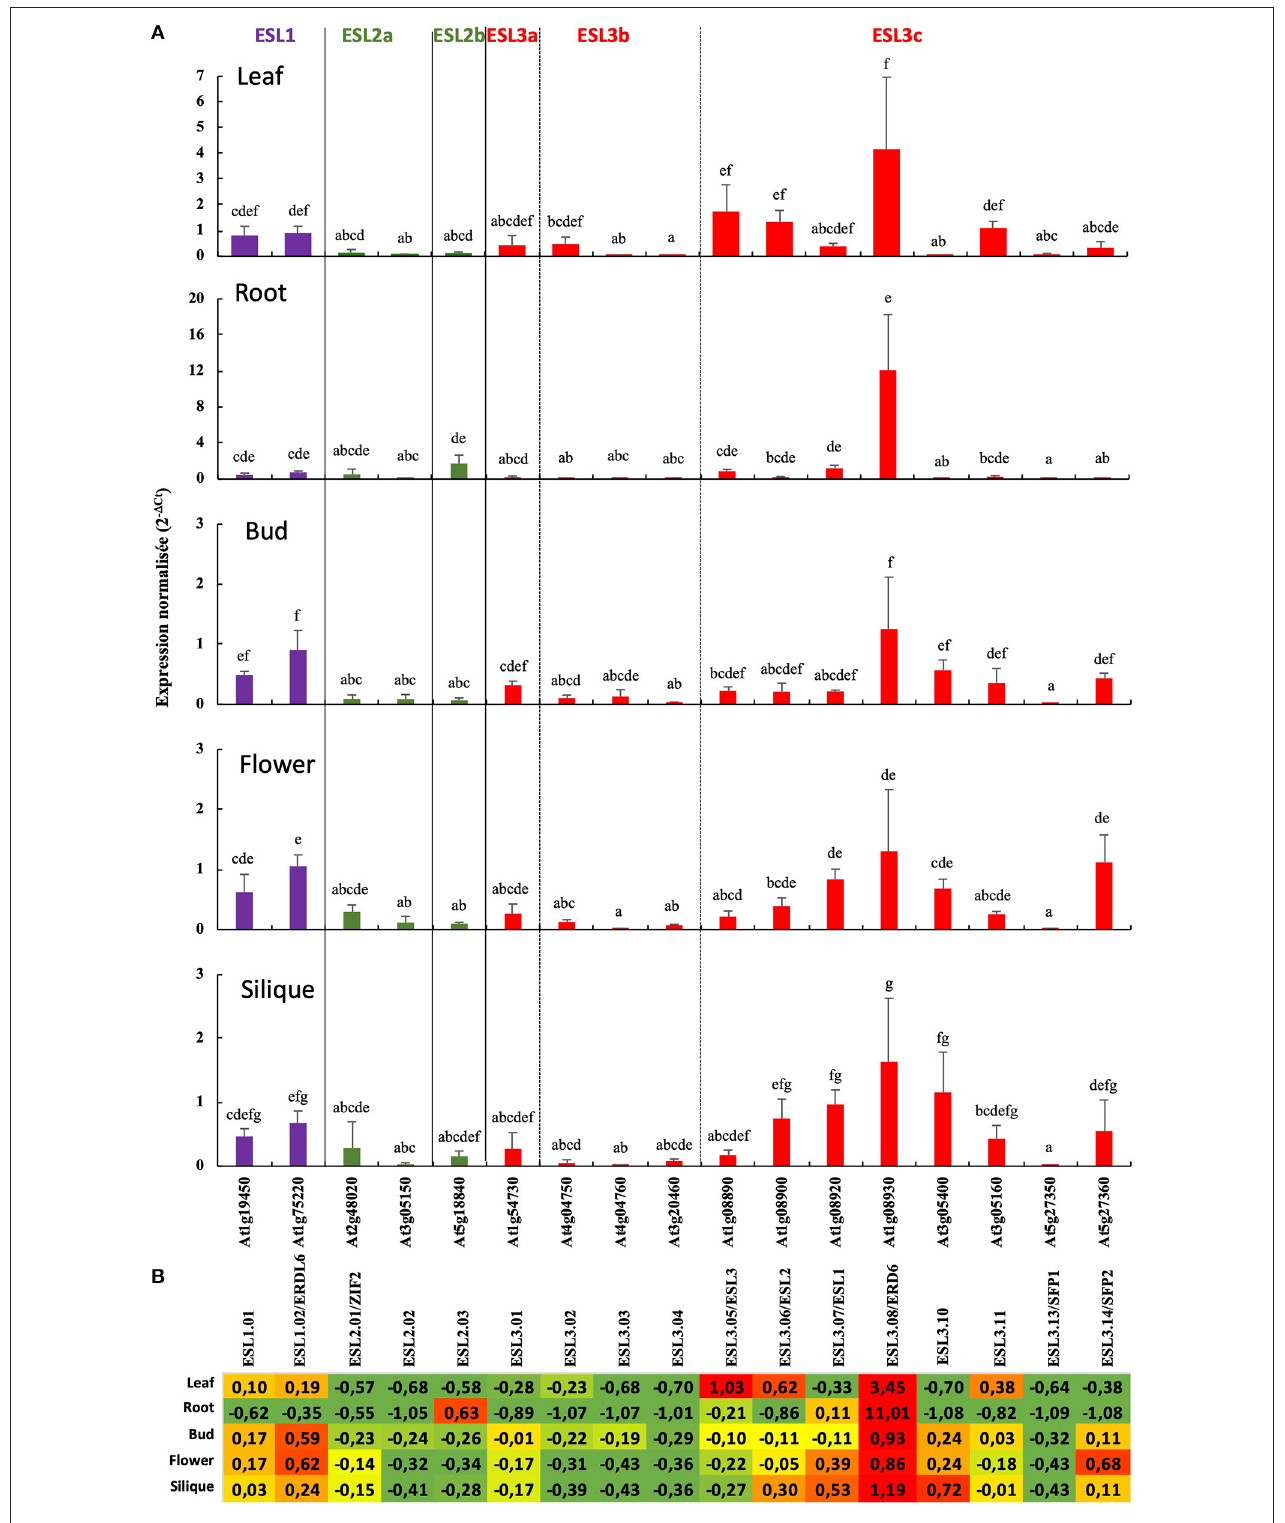
FIGURE 11 | The relative expression of 17 A. thaliana ESL genes in different organs measured by real-time reverse transcription-PCR (qRT-PCR). (A) The 2 − 1 Ct values are normalized according to AtPP2a expression and represent the mean of 3 biological repeats (ecartype). Statistical analysis was performed using the Kruskal-Wallis test and the multiple comparison test of Dunn corrected by Bonferroni. Values significantly different are indicated by distinct letters. Purple is for ESL1 ,